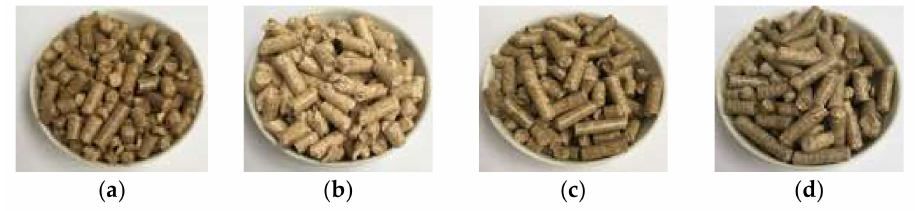
Figure 1. Samples of pellets: ( a ) S–100 ( b ) SD–100 ( c ) SSPS–45/45/10 ( d ) SSPS–40/40/20.